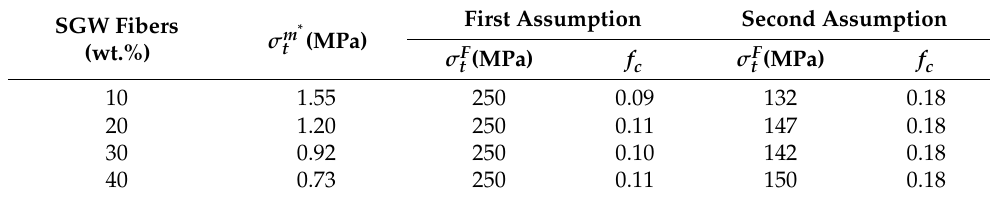
Table 8. Results of the application of the modified rule of mixtures under two assumptions. SGW Fibers (wt.%)